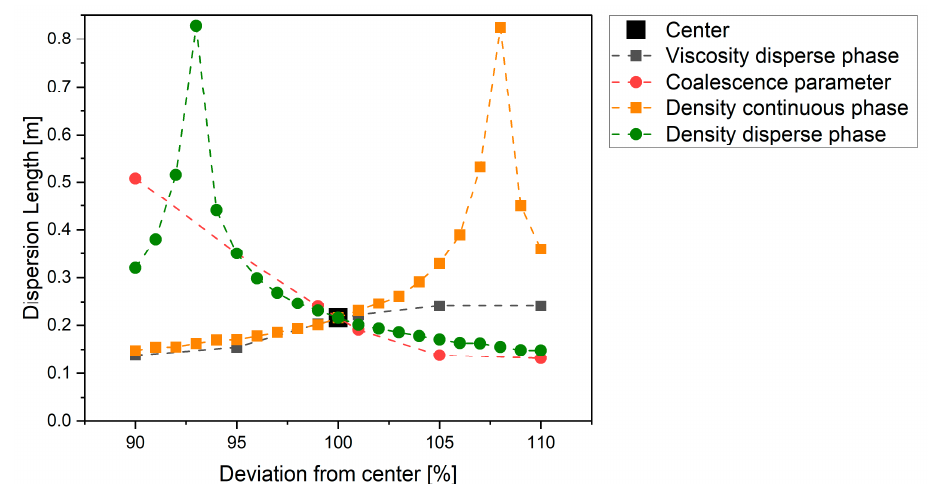
Figure 15. Plot of OFAT results with fine parameter variation.